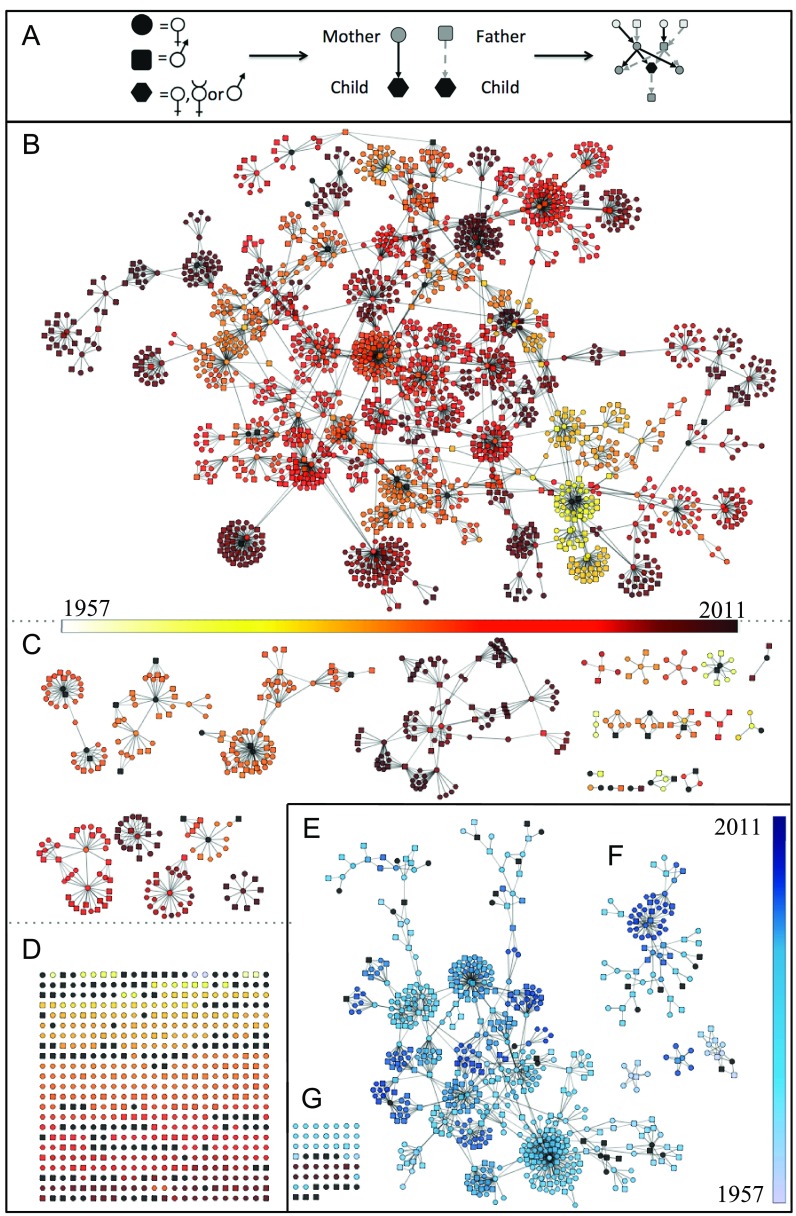
Genealogies represented as kinship directed acyclic graphs (kDAGs).Each individual is represented as a node and parent nodes are connected to offspring nodes by directed edges (
A), for the North American (
B–
D) and Australasian (
E–
F) meerkat populations. Both graphs collapse to one major cluster (
B,
E), many smaller unconnected sub-graphs (
C,
F), and a set of unconnected nodes (
D,
G). Variation in birth dates is indicated by color gradients. Individuals with inaccurate (to month) or unknown dates of birth are shown as black nodes.